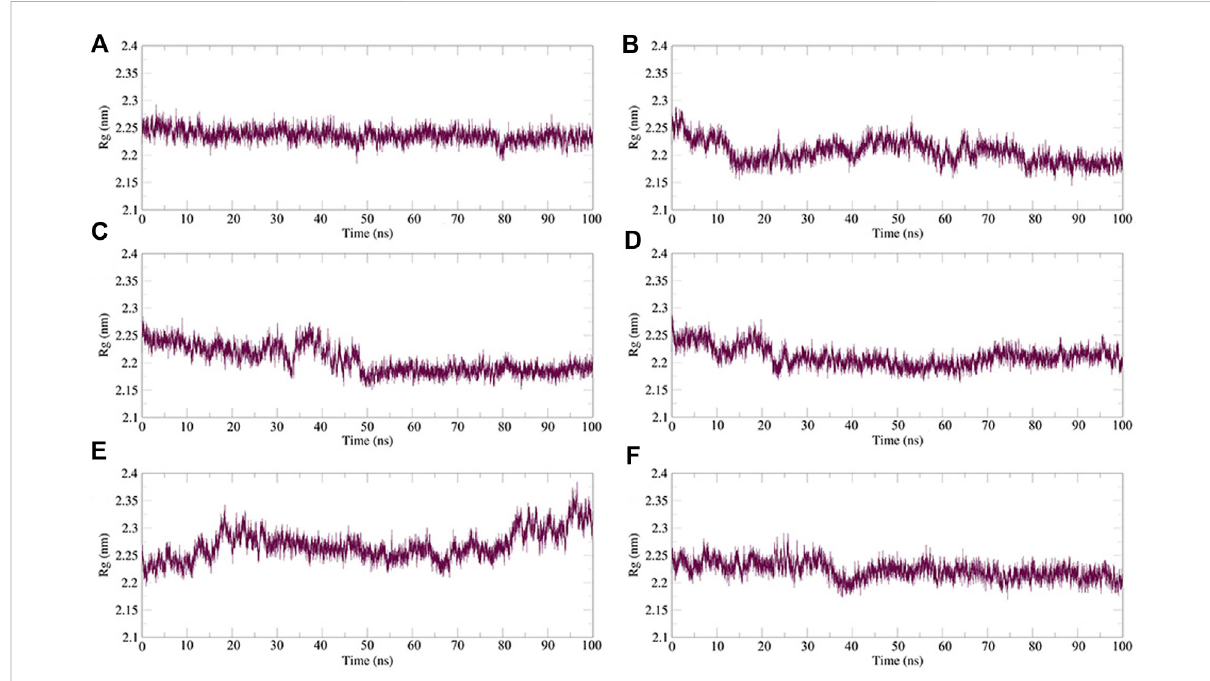
FIGURE 12 Plotofradiusofgyration(Rg)values,during100nsMDsimulationofcompound – M pro complexes. (A) N3 – M pro Rg; (B)